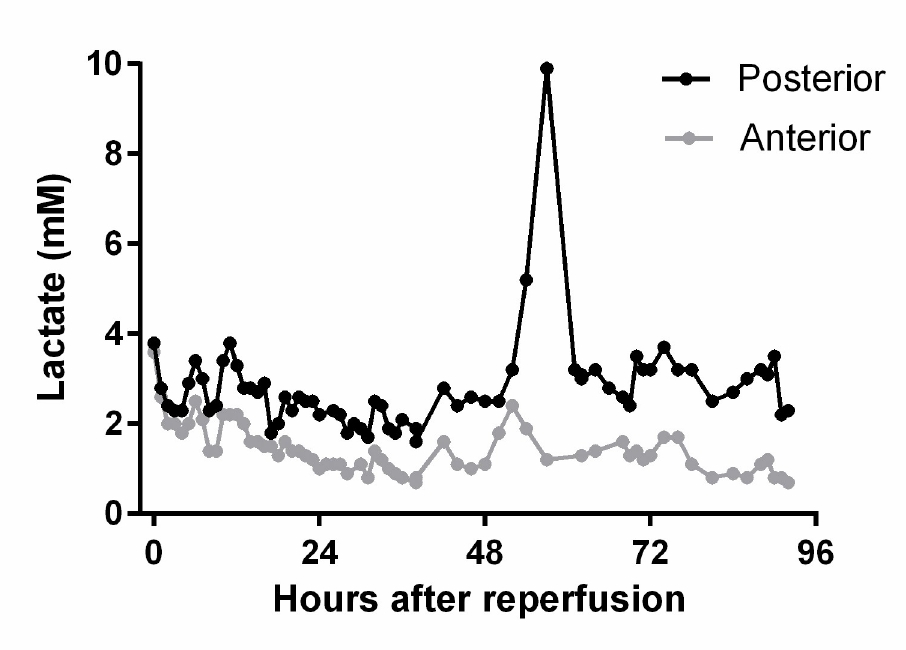
Fig 3. Microdialysis lactate elevation. Lactate concentration in a pancreas graft with venous thrombus, measured in microdialysate sampled posterior and ventral to the transplanted pancreas. Notice the peak in the posterior lactate level, followed by a rapid fall after circulation was re-established by thrombus